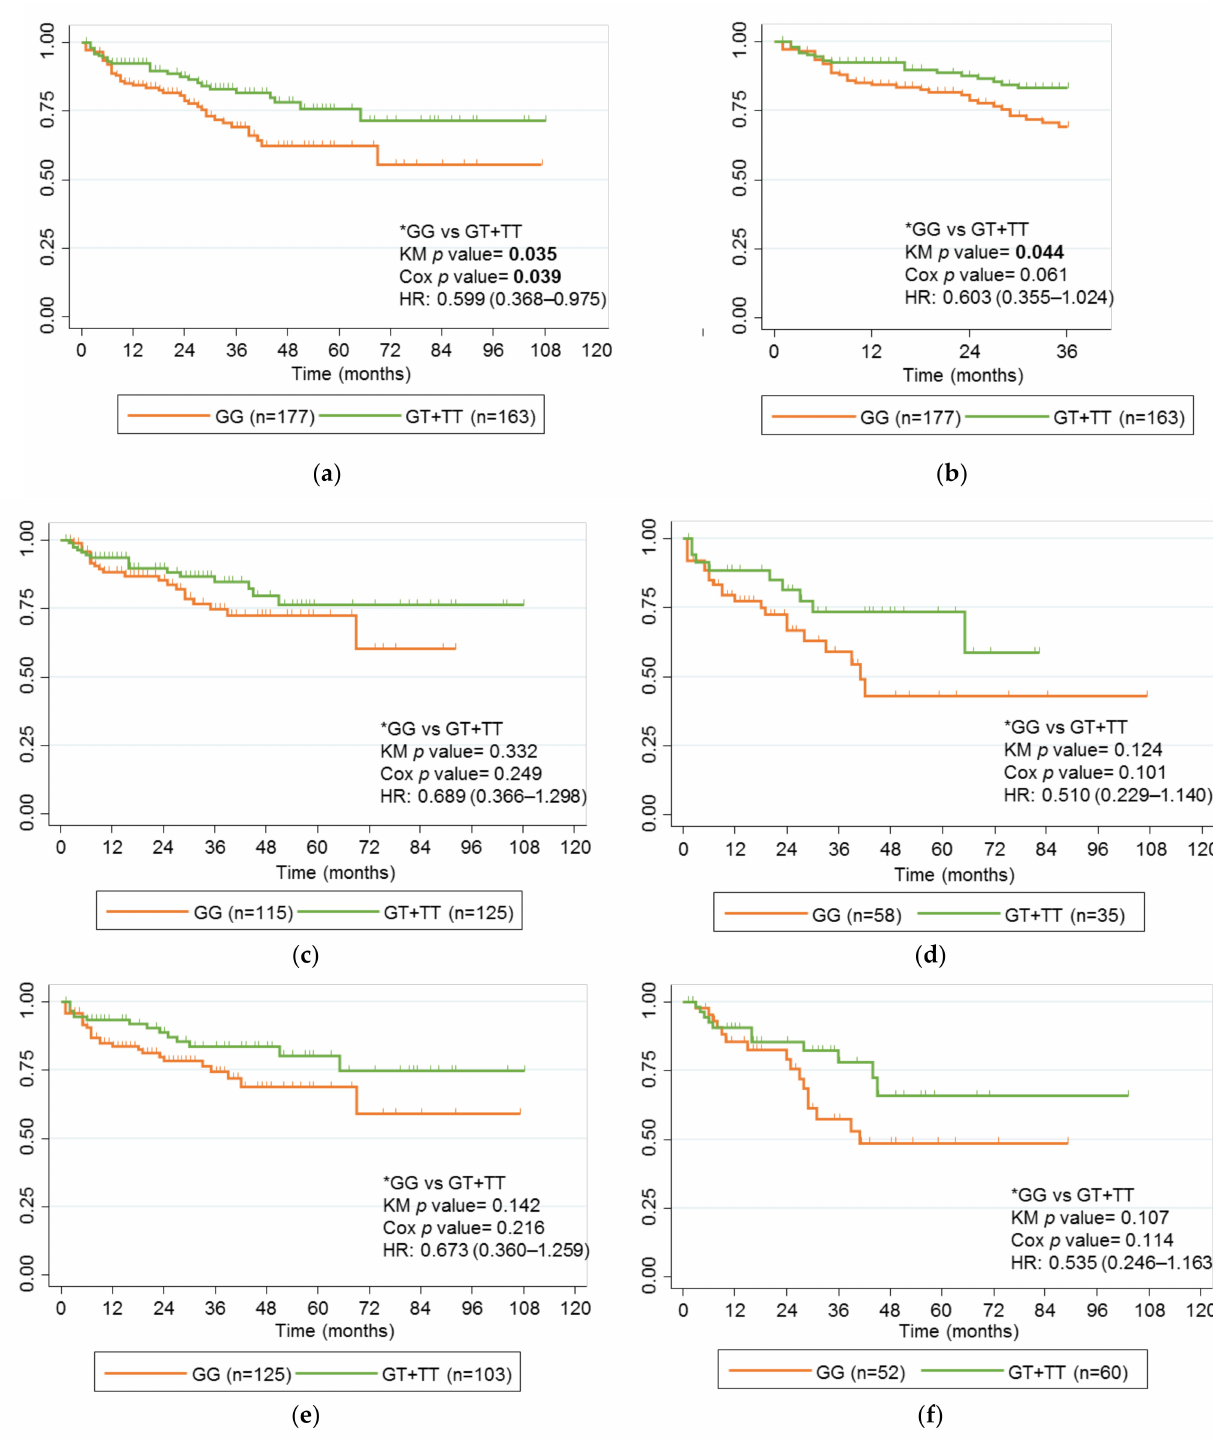
Figure 2. Kaplan-Meier curves for rs2395185 and failure of anti-TNF therapy. ( a ) Children with IBD treated with anti-TNF drugs; ( b ) Children with IBD treated with anti-TNF drugs for 36 months; ( c ) Children with CD treated with anti-TNF drugs; ( d ) Children with UC treated with anti-TNF drugs; ( e ) Children with IBD treated with IFX; ( f ) Children with IBD treated with ADL. Genotype comparisons and p values for univariate analysis (KM p value) and multivariate analysis (Cox p value) are presented alongside Kaplan-Meier curves. Significant p values are marked in bold. * Reference